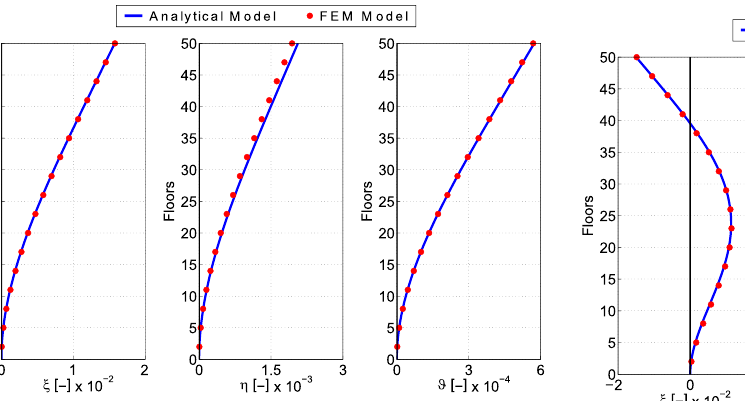
Figure 7: Normalized eigenvector components of the 4th mode